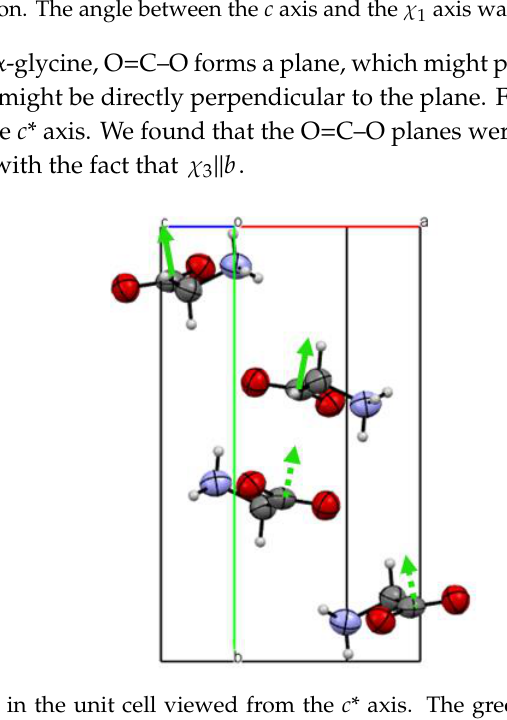
Figure 7. Molecules in the unit cell viewed from the c * axis. The green arrows are the directions perpendicular to the planes formed by O=C – O.